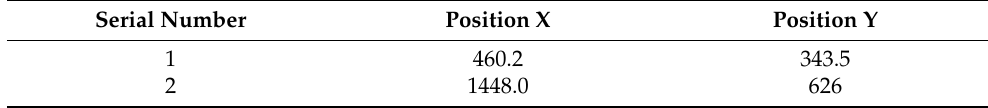
Table 2. Dynamic target position.